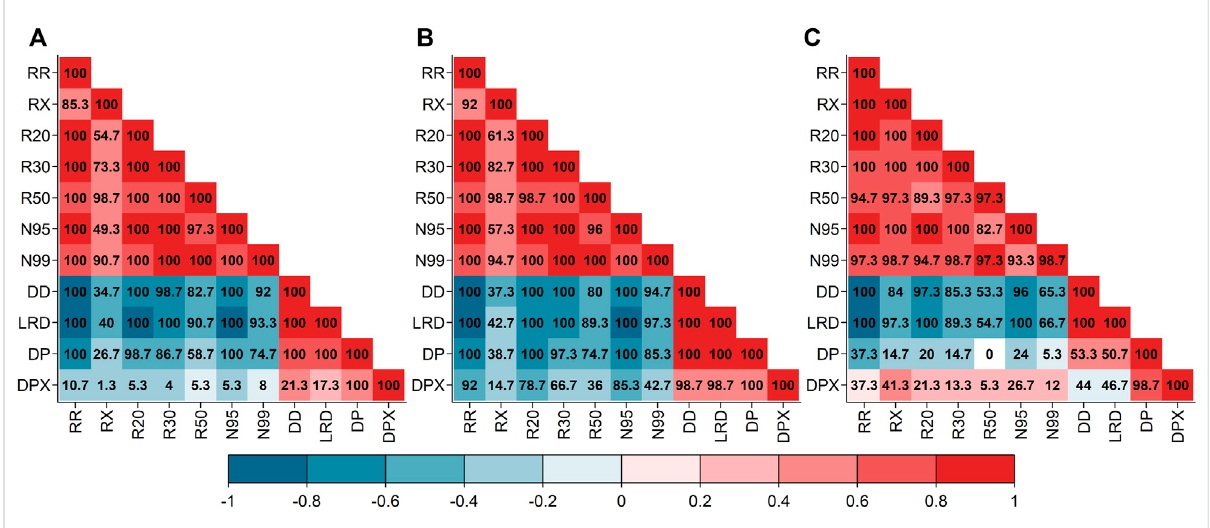
FIGURE 8 Percentage of target stations (inside the squares) with the average of the Pearson correlation coef fi cients at the 5% signi fi cant level between precipitation indices during the (A) annual period, (B) rainy season and (C) dry season from 1974 to